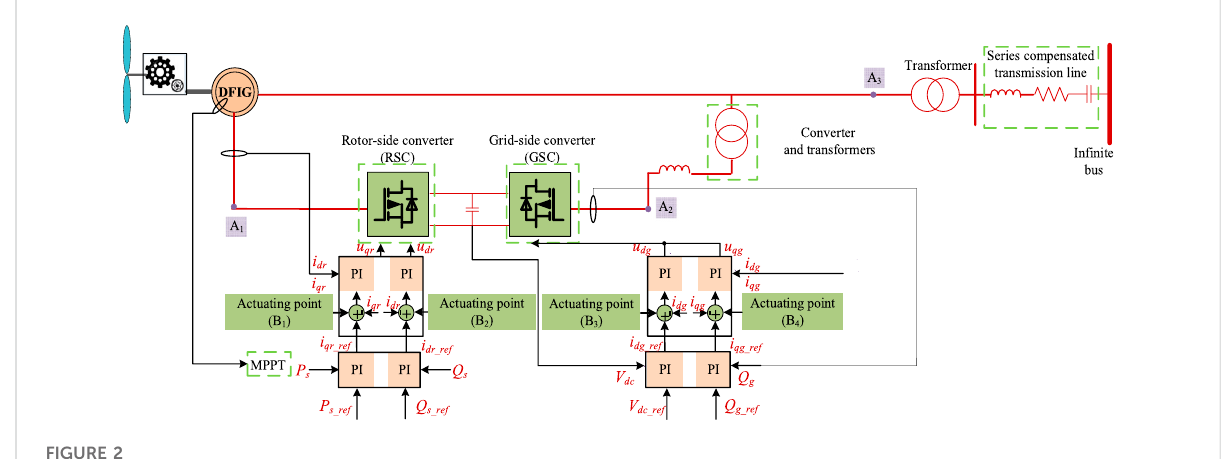
FIGURE 2 DFIG system and the feasible positions of monitoring points and actuating points.